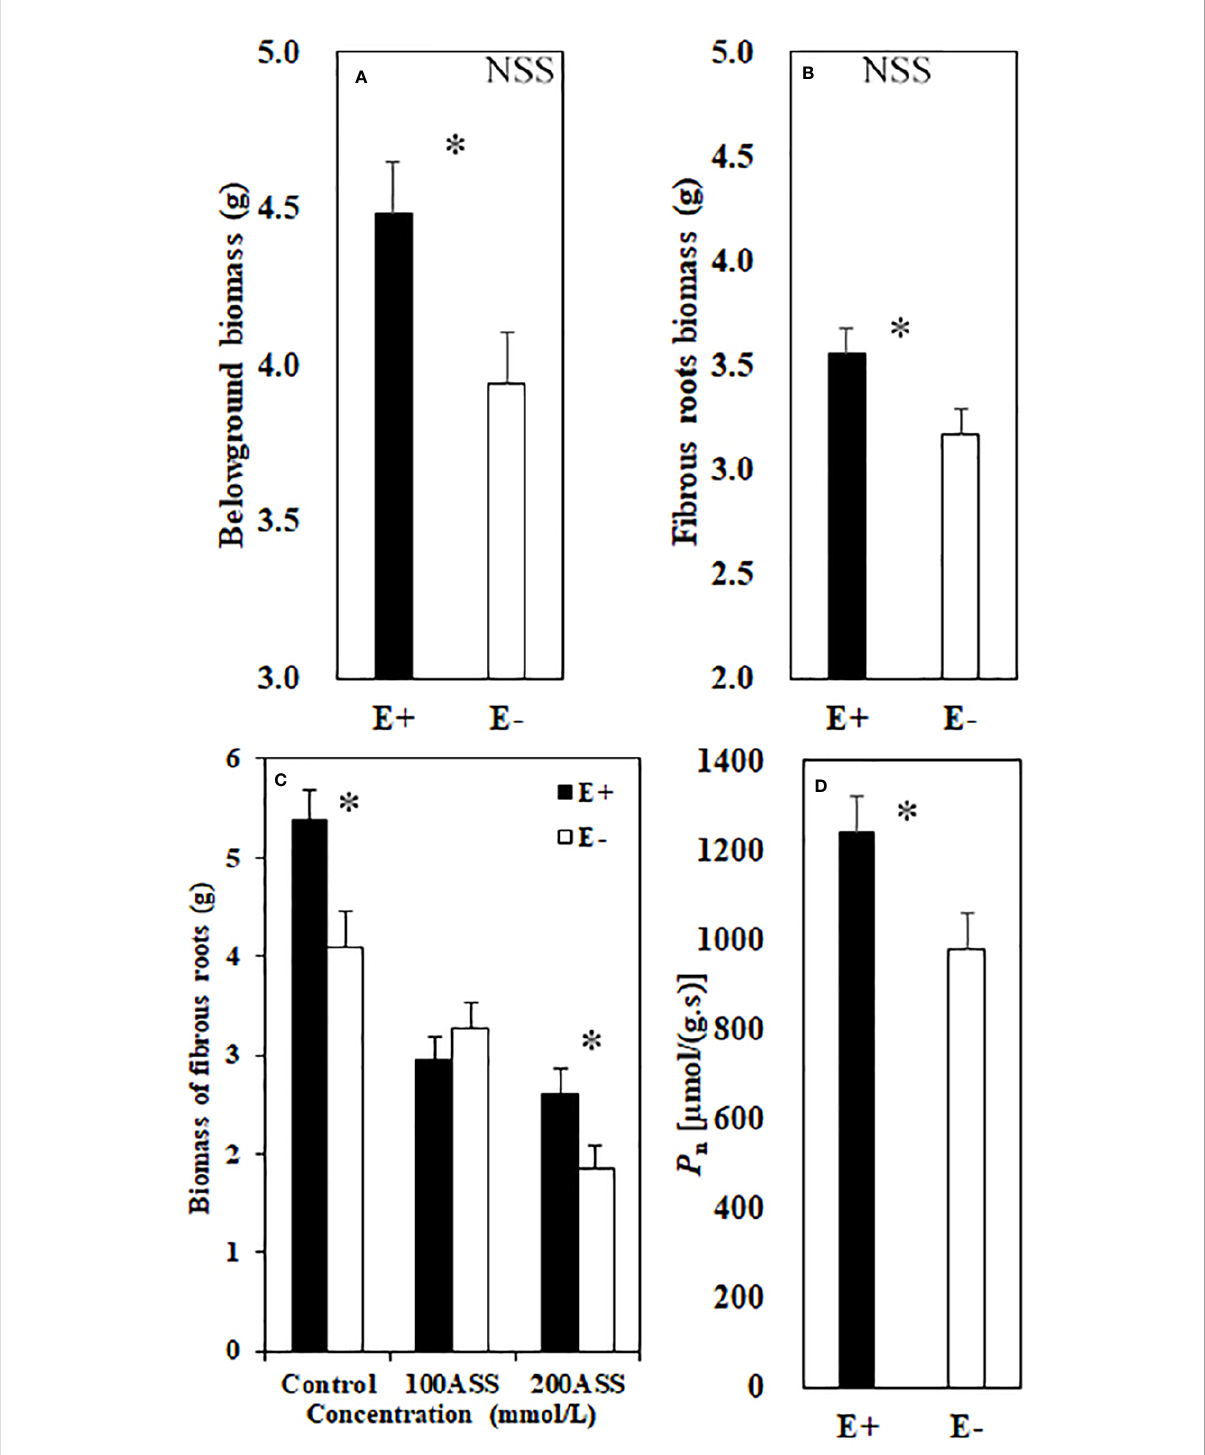
FIGURE 2 Belowground biomass (A) and fi brous root biomass (B) under neutral salt stress (NSS) and fi brous root biomass (C) under alkali salt stress (ASS) of endophyte infected (E+) and uninfected (E − ) L. chinensis . P n rate (D) . Values are mean ± standard error. * indicates signi fi cant difference at p <